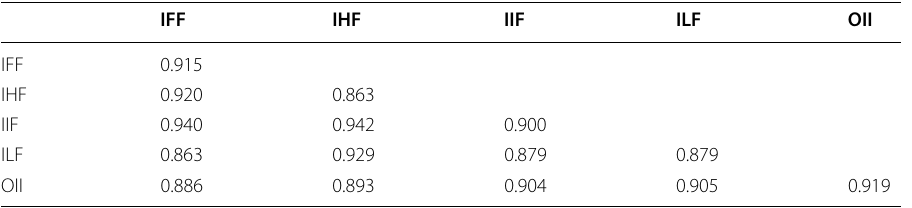
Table 5 Fornell–Larcker criterion analysis for checking discriminant validity